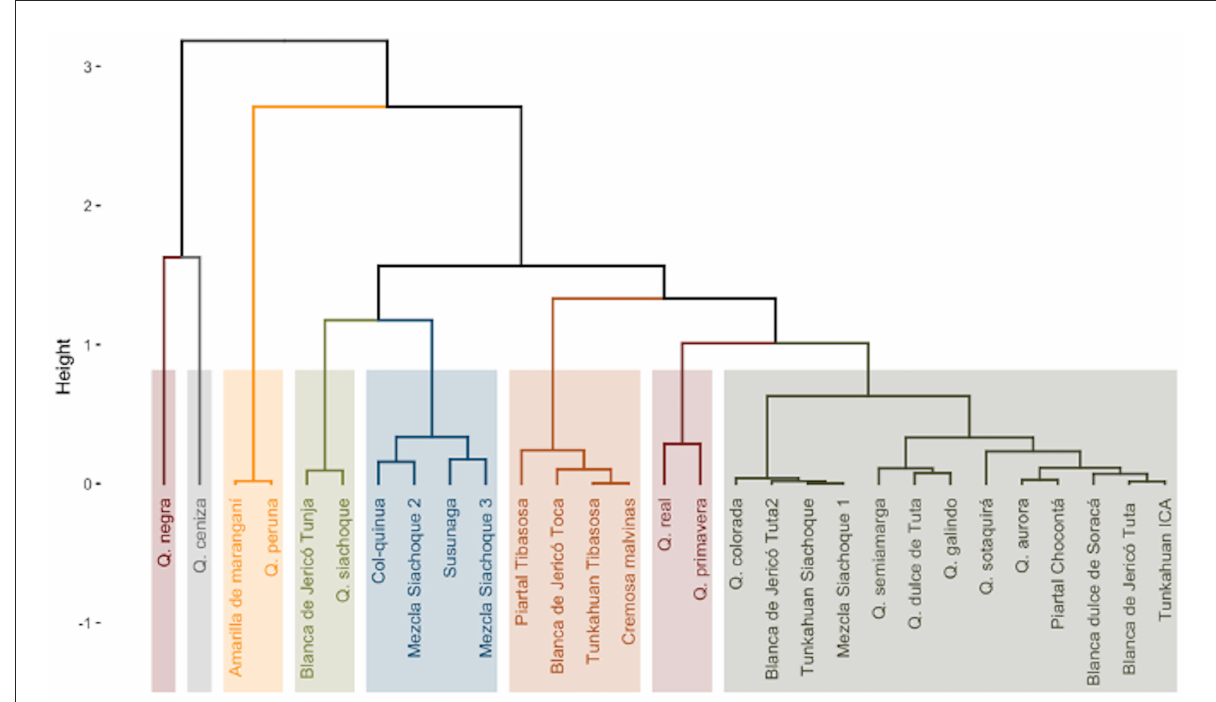
FIGURE4 Cluster analysis, eight groups of accessions formed according to the qualitative and quantitative variables evaluated in 30 quinoa accessions. Footnote: GD grain diameter, WS weight of 1,000 seeds, Y yield, M days to physiological maturity, S concentration of triterpene saponins, GS grain shape, GE grain edge, CE grain edge, CP color of the